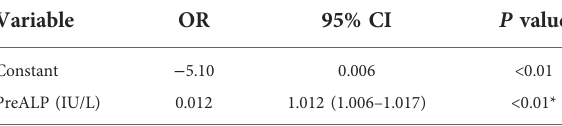
TABLE 2 In fl uencing factors of postoperative HBS (logistic regression